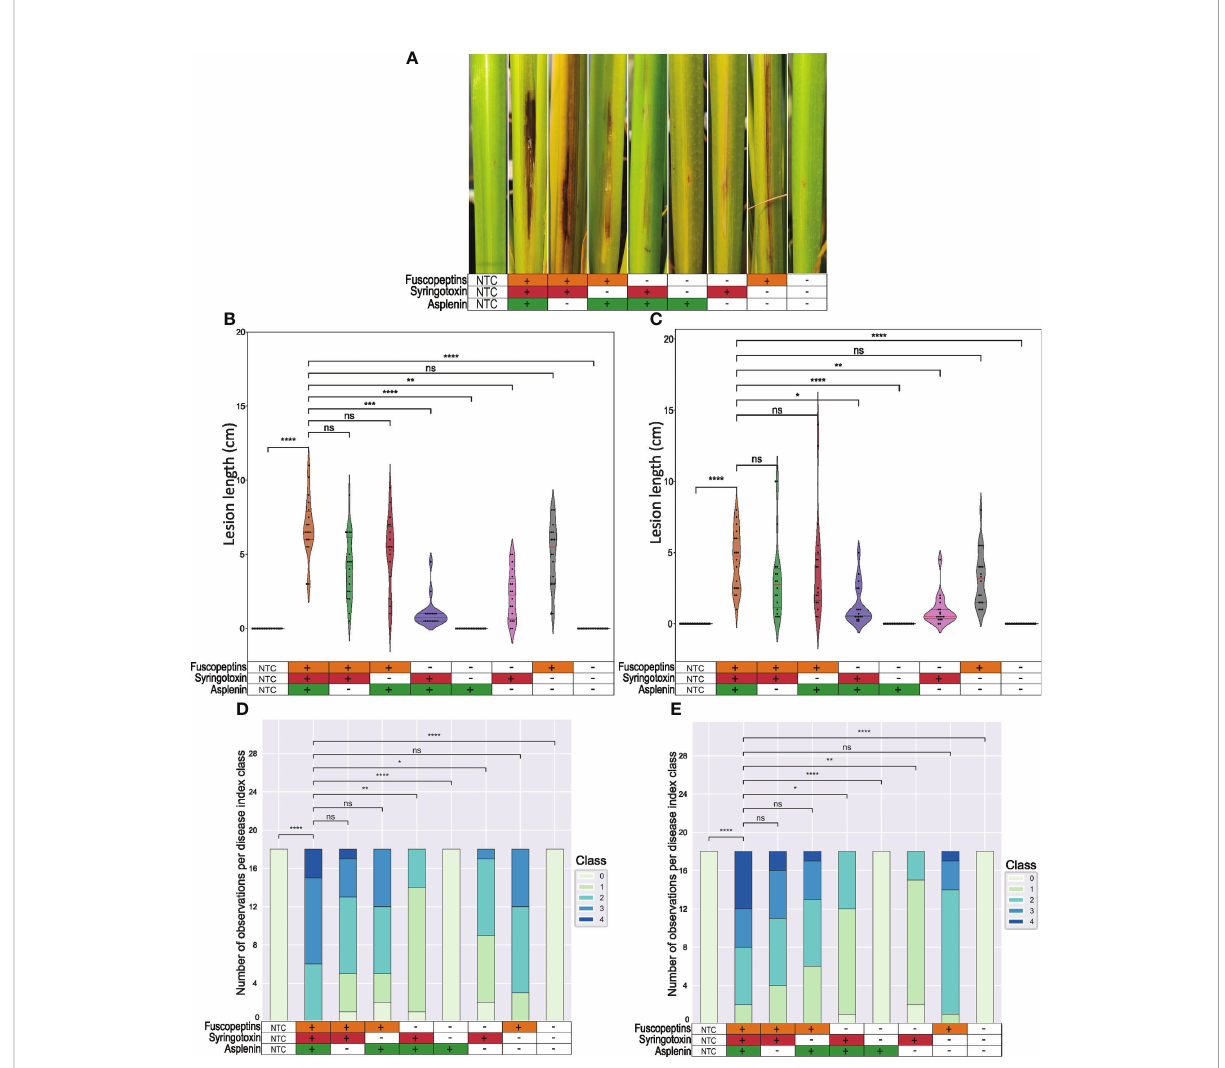
FIGURE 4 Sheath brown rot symptoms caused by P. fuscovaginae UPB0736 and CLP mutants. Rice plants were inoculated by injecting a bacterial suspension of P. fuscovaginae UPB0736 WT or mutants for the indicated CLPs. The non-treated controls (NTCs) were injected with saline solution. (A) Representative sheath rot symptoms on the infected tiller 7 days post-inoculation (scoring time). (B, C) Violin plot showing the length of the necrotic lesions. Dots indicate the measurements for each plant. The red and the two grey lines are respectively the median and the two quartiles. (D, E) Stack graphs showing the lesion type based on a 0-4 disease index, in order: no symptoms, only injection puncture; brown necrosis around the injection point with grey stripes; light brown to grey symptoms with some small lesions; intense brown necrosis; strong necrosis from dark brown to black and clear lesions on the stem. Plants were infected about (B, D) one week or (C, E) two weeks before the start of the booting stage. Tables below the fi gures refer to the phenotypes of WT and CLP mutants, as indicated in Table 3. Statistical signi fi cance was calculated with Kruskal-Wallis and post hoc pairwise Dunn tests with Holm-Sidak correction. ****, p ≤ 1.00e-04; ***, 1.00e-04 <p ≤ 1.00e-03; **, 1.00e-03<p ≤ 1.00e-02; *, 1.00e-02<p ≤ 5.00e-02; ns, not signi fi cant. The pairwise p-values arrays are available in Tables S5 to